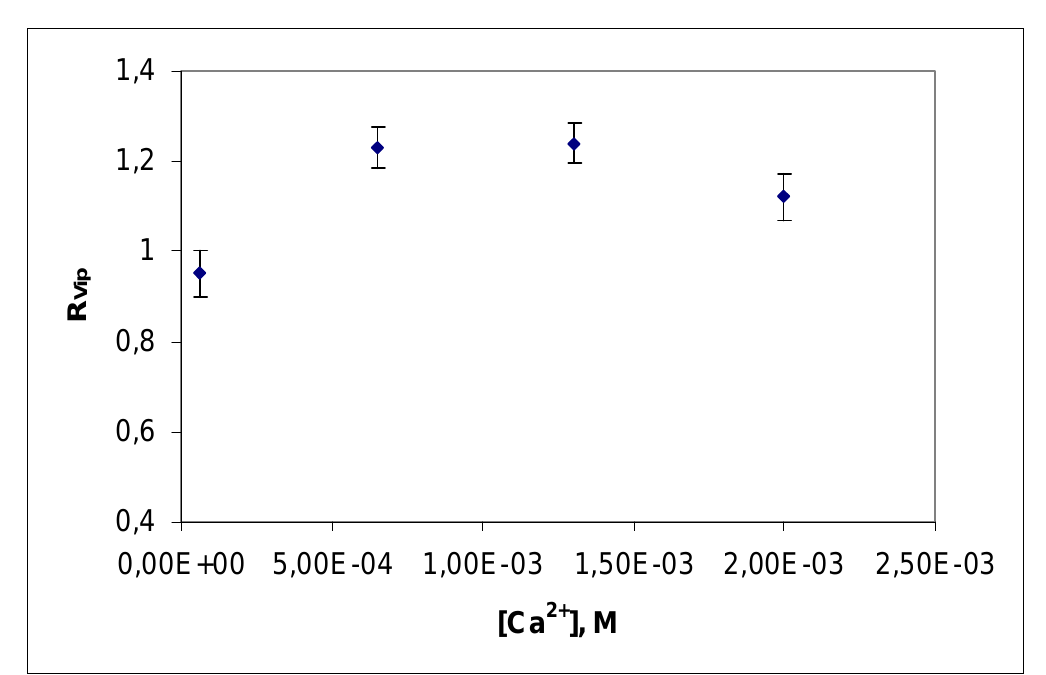
Figure 2: Dependence of the enzymatic activity on Ca 2+ concentration. R amount of fatty acids released in presence of Ca 2+ ions to the amount of the ones released in absence of Ca 2+ . Incubation time: 25 min at the conditions described in the text.